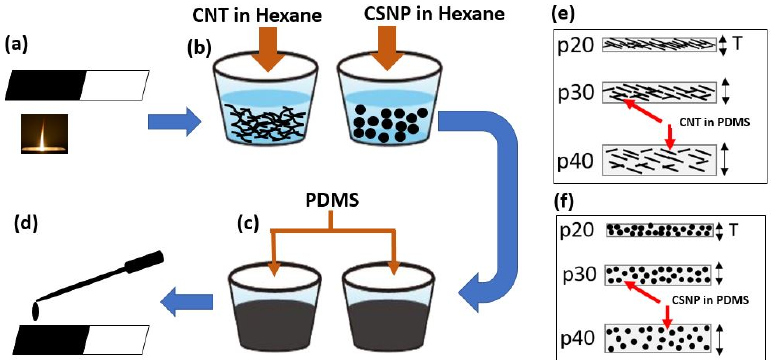
Figure 1. ( a – d ) Stepwise fabrication details to develop carbon nanoparticle-based PA transmitters. ( a ) Collection of CSNP from candle flame, ( b ) Mixing CNT and CSNP in hexane and sonicating for 2 h, ( c ) Adding PDMS to sonicated solution, ( d ) Drop-casting the prepared solution on glass sub- strate, ( e , f ) A simplified schematic to represent nanoparticle concentration and thickness (T) of CNT